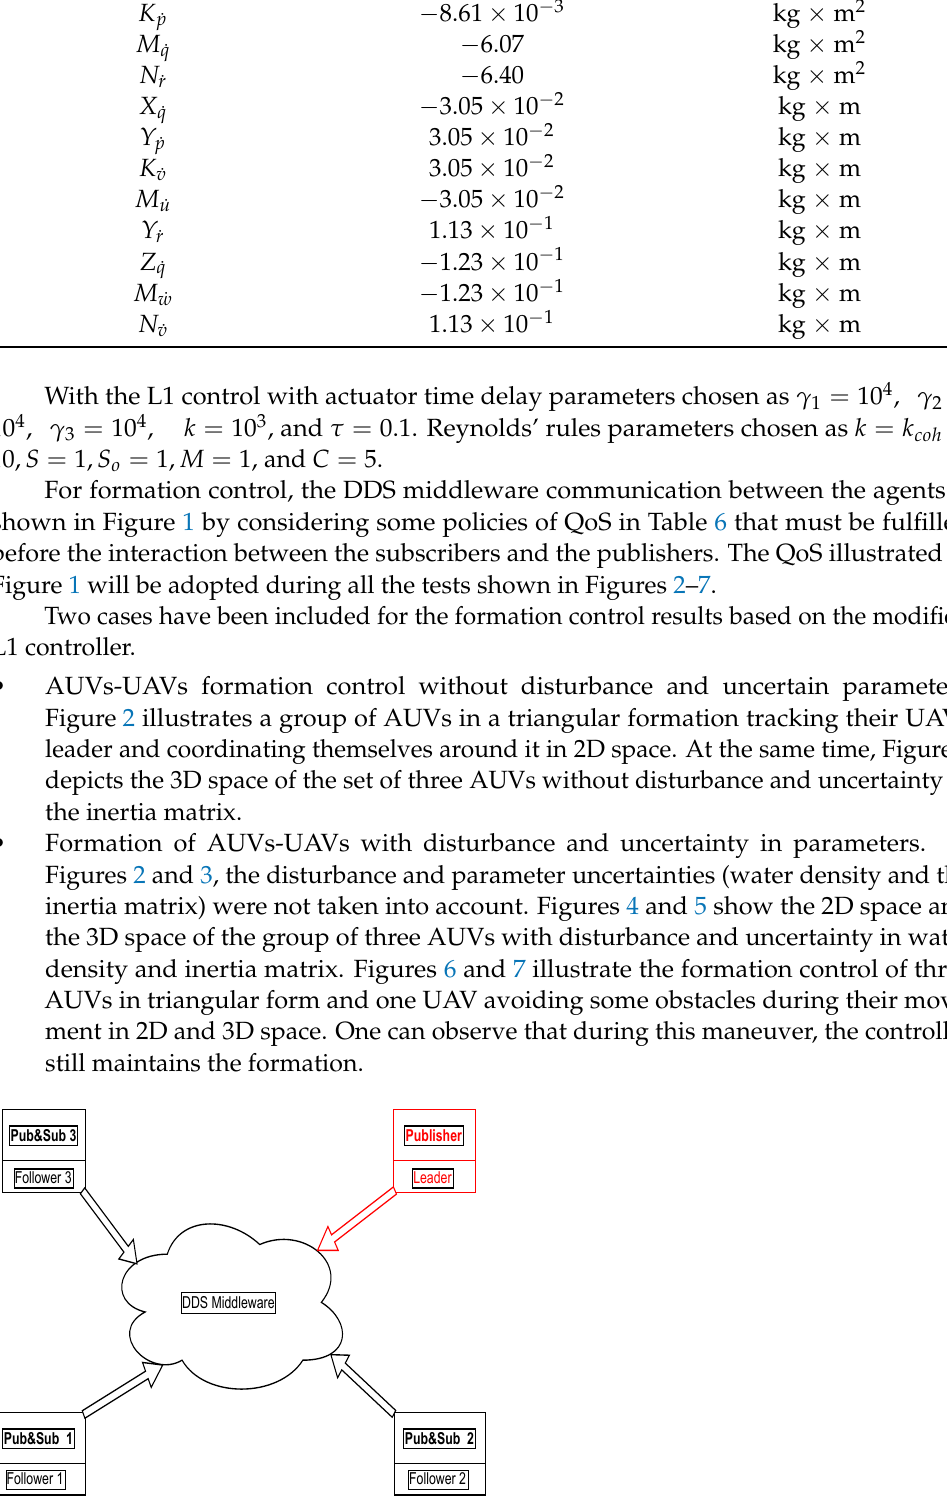
Figure 1. The formation structure based on DDS